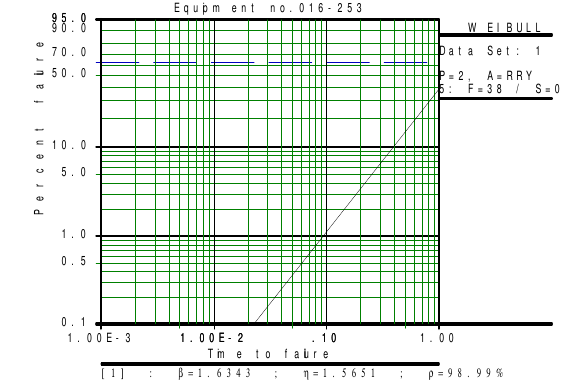
Fig. 3: Time to failure vs. percent failed Fig. 4 shows the Probability Density Function (PDF) for the equipment No. 016-253.